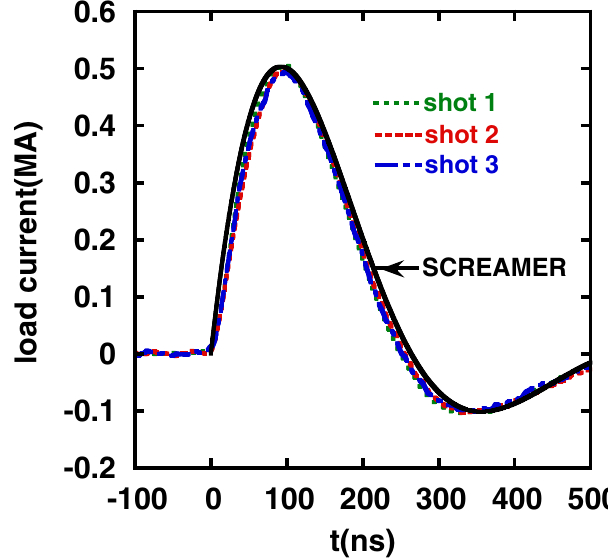
FIG. 11. (Color) Comparison of three output current traces obtained of the prototype LTD I cavity with the SCREAMER circuit code